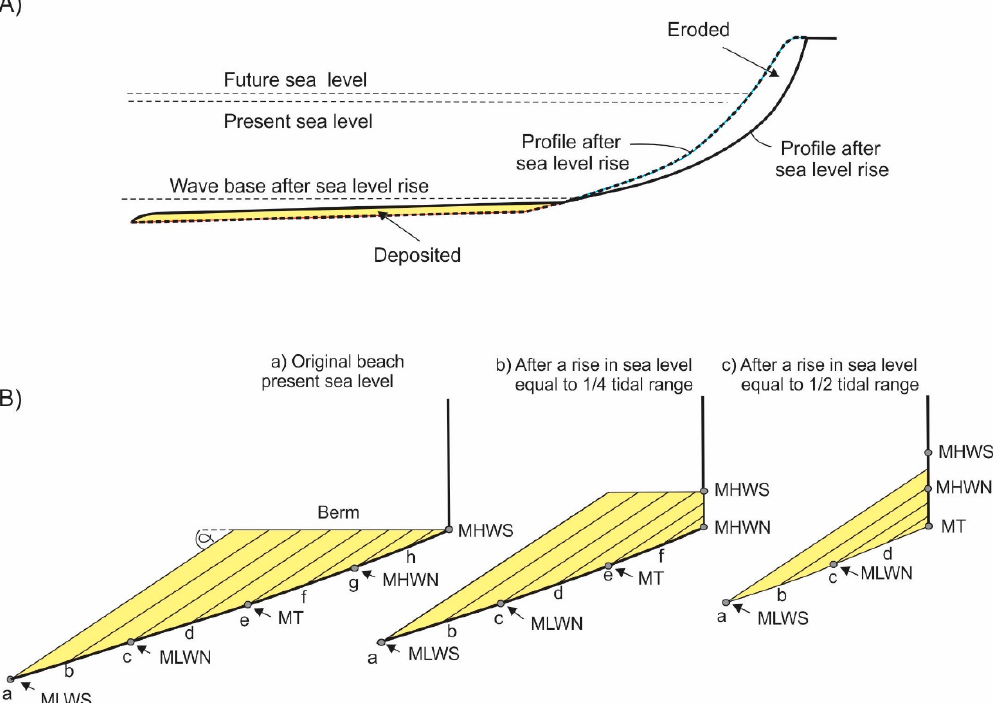
Figure 4. ( A ) The Bruun Rule suggests that a rise in sea level causes a concordant upward and landward migration of the equilibrium beach profile, with the rise in the water surface being matched by the rise in the nearshore bottom. The sediment needed to raise the floor and maintain the original bottom profile is obtained through erosion on the upper part of the beach. ( B ) Modelling the morphodynamics and response to changing sea level of beaches with resistant foundations. The model is shown with (a) present sea level and with two (b,c) higher sea levels. The letters below the beach profiles (a to h), for each of the three sea levels, refer to stages in model calculations to determine if a beach can develop on the resistant foundation under prevailing conditions. Beach extent and morphology change during model runs according to the amount and grain size of the available sediment, the relationship between beachface gradient and the gradient of the resistant foundation, and the beach state, which depends in turn on the prevailing wave conditions. MHWS, MHWN, MT, MLWN, and MLWS refer to mean high water springs, mean high water neap, mid-tide, mean low water neap, and mean low water spring tidal levels, respectively. The shaded (yellow) parts of this figure represent beach sediment and α is the gradient of the beachface. See Trenhaile [40] for a detailed explanation of this